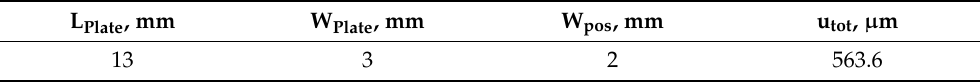
Table 4. Summary of the results from optimization problems.